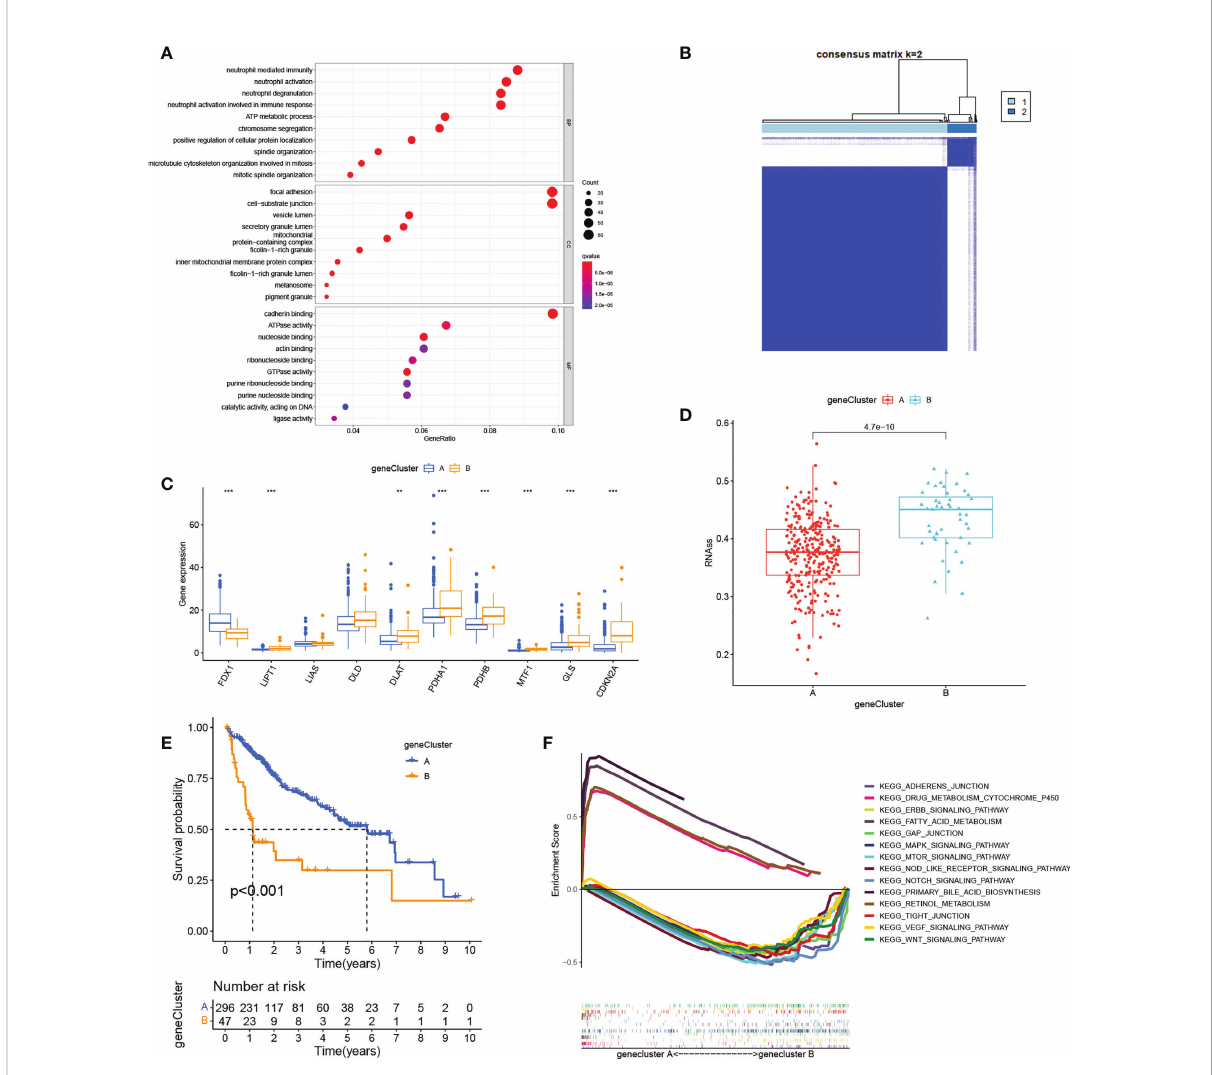
FIGURE 3 Gene cluster determination. (A) GO enrichment analysis of cuproptosis-related DEGs. (B) Consensus matrix based on cuproptosis-related gene expression in the HCC cohort at k = 2. (C) Differential expression of cuproptosis regulators in the two clusters. (D) RNAss values of cuproptosis regulators in the two clusters. (E) K-M survival analysis of cuproptosis regulators in the two clusters. (F) Multiple GSEA analysis between the two clusters. **P < 0.01; ***P < 0.001. GO, Gene Ontology; DEGs, differentially expressed genes; HCC, liver hepatocellular carcinoma; RNAss, RNA stemness scores; K-M, Kaplan-Meier; GSEA, gene set enrichment